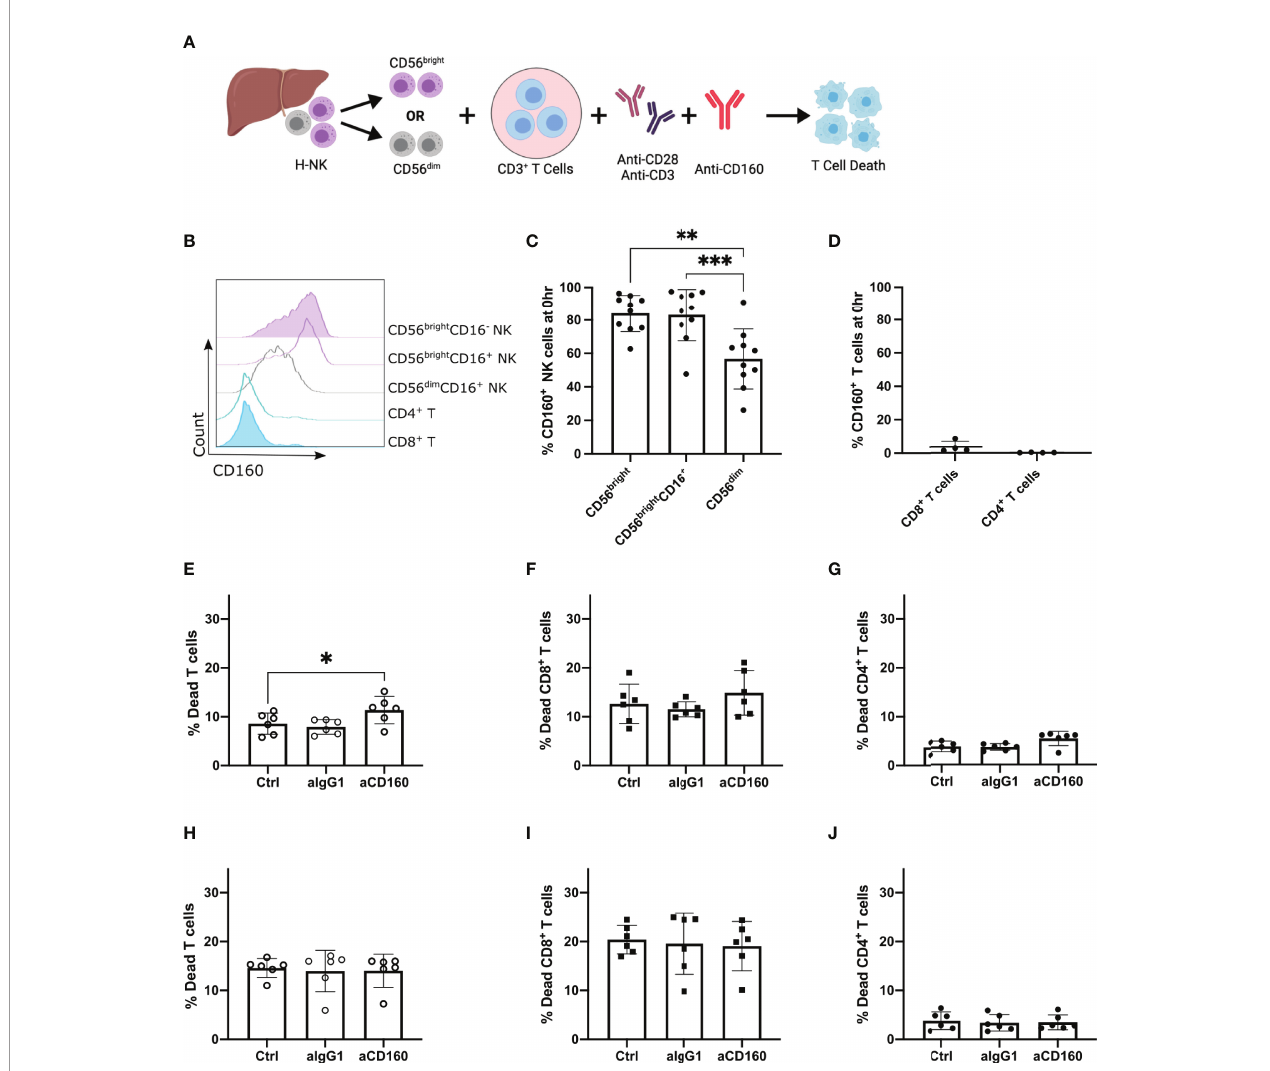
FIGURE 5 | Agonistic anti-CD160 mAb acts on hepatic CD56 bright NK cells to enhance their killing of allogenic T cells. Activated CD3 + T cells co-cultured with H-NK cells or FACS-sorted hepatic CD56 bright CD16 +/- or CD56 dim CD16 + NK cells with or without a mAb against CD160 for 24 hr (n = 6-10). (A) , Schematic of experimental design (B), Representative fl ow plot of CD160 expression on NK and T cell populations at 0 hr prior to coculture. ‘ Ctrl ’ indicates cocultures of CD3 + T cells with the speci fi ed H-NK cell subset without the addition of any antibody. ‘ aIgG1 ’ indicates cocultures of CD3 + T cells with the speci fi ed H-NK cell subset with the addition of an IgG1 antibody. ‘ aCD160 ’ indicates cocultures of CD3 + T cells with the speci fi ed H-NK cell subset with the addition of an anti-CD160 mAb. (C, D), Percent CD160 expression on NK cell (C) and T cell (D) subsets at 0 hr. (E – G), Percent dead total T cells (E) , CD8 + T cells (F) and CD4 + T cells (G) following 24 hr co-culture of CD3 + T cells and CD56 bright CD16 +/ - hepatic NK cells. (H – J) , Percent dead CD56 - CD19 - cells (H) , CD8 + T cells (I) and CD4 + T cells (J) following 24 hr co-culture of CD3 + T cells with hepatic CD56 dim CD16 + NK cells. Data analysed using a repeated measures One Way ANOVA test (C – J) . * p< 0.05, **p < 0.01, and ***p <